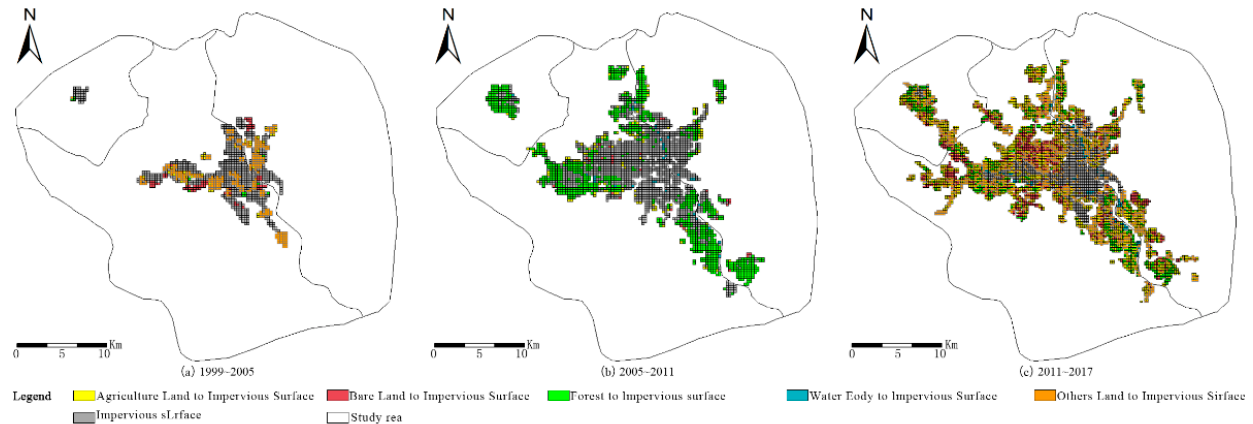
Figure 3. Conversation-into urban impervious surface in 1999–2017.